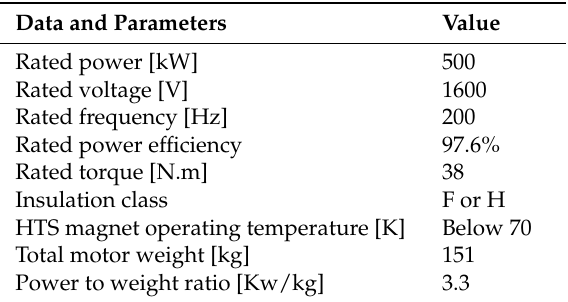
Figure 14. The curves of induced electromotive force and efficiency with load factor. Table 4. Electromagnetic parameters of designed